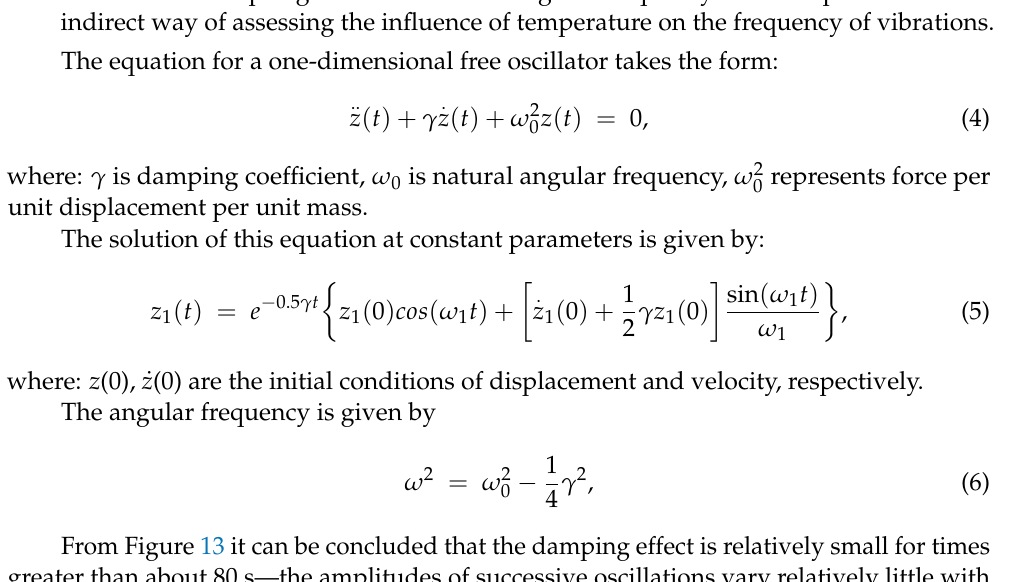
Figure 16. Relationship between natural frequency and vibration amplitude of the contact wire at different wire temperatures.